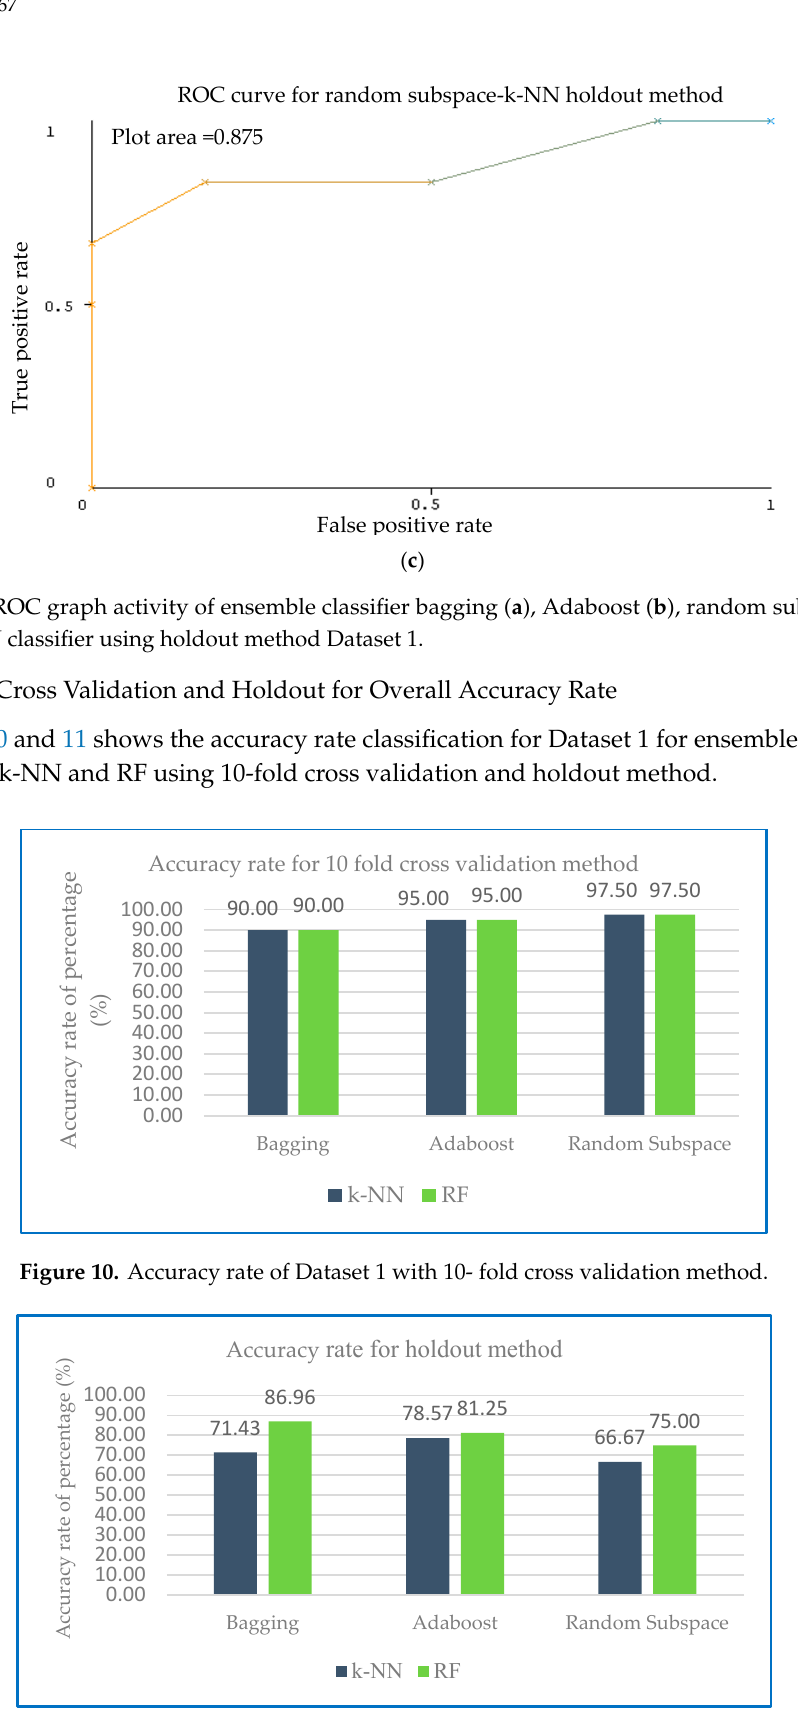
Figure 11. Accuracy rate of Dataset 1 with holdout method.